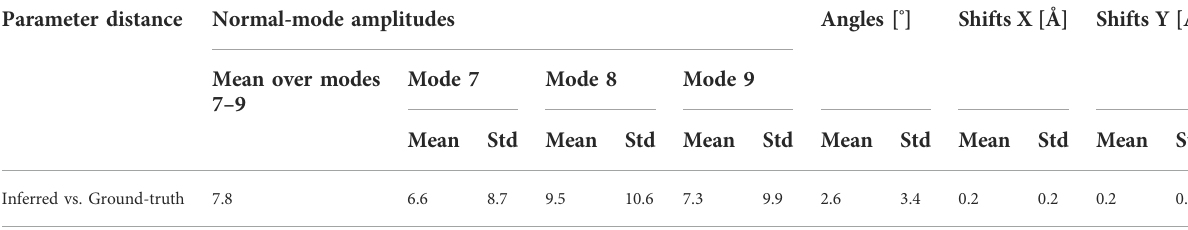
TABLE 3 Mean and standard deviation (Std) of the distance between inferred and ground-truth values of parameters (normal-mode amplitudes, angles, and shifts) for a large test set of 50,000 synthetic images (the data used to test the generalization of the fi nally trained network on a large set of images).